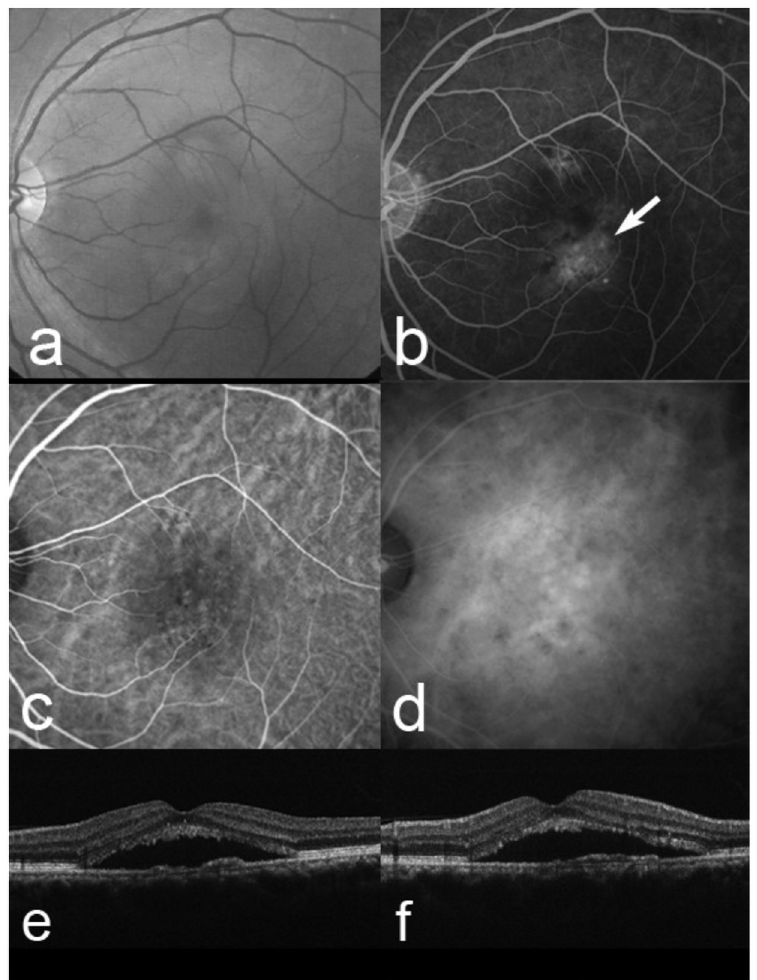
Fig 6. A 56-year-old man whose diagnosis changed from typical age-related macular degeneration (AMD) to polypoidal choroidal vasculopathy. At baseline, the best-corrected visual acuity (VA) is 0.7 decimal VA (Snellen equivalent, 20/28) in the left eye. (a) A red-free fundus photograph shows a serous retinal detachment (SRD). (b) Fluorescein angiography shows occult with no classic choroidal neovascularization (CNV) (arrow). Early-phase (c) and late-phase (d) indocyanine green angiography images show no polypoidal lesions. Horizontal (e) and a vertical (f) optical coherence tomography images show a SRD. This patient was diagnoses with typical AMD associated with occult with no classic